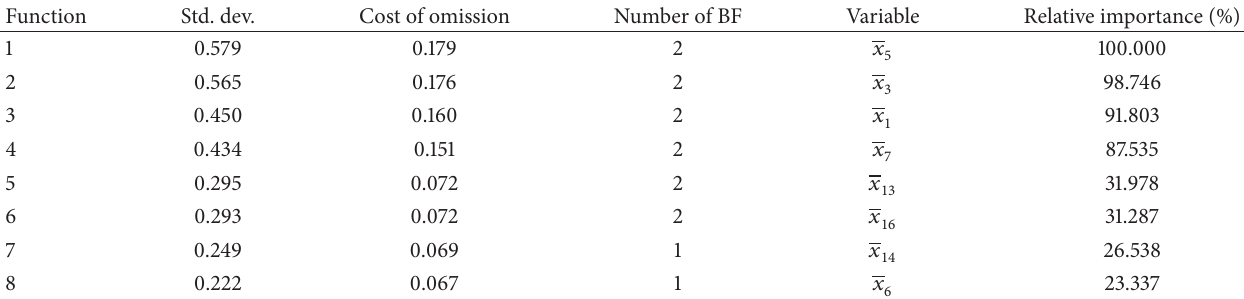
Table 8: Basis functions and important explanatory variables for the MARS model with ( 𝜌 , 𝛿 𝑖 ) = (0.9, 1.0). Function